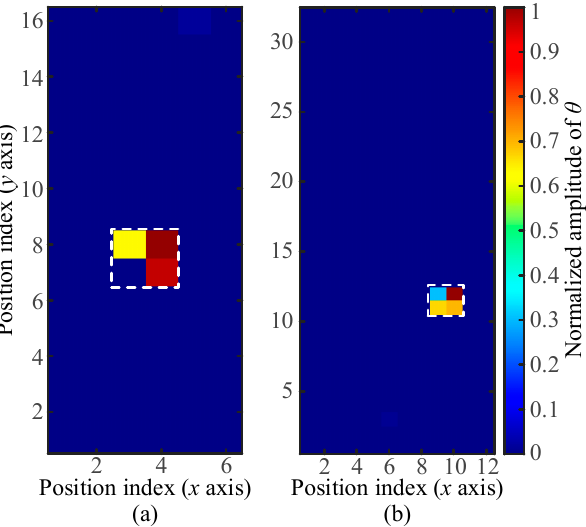
Figure 9. Localization results of a large-area touch with the reference database of a small area under the equivalent condition of averaged stress: ( a ) Localization results of unknown touch and the reference database with the A t combination of 64 and 16 mm 2 and ( b ) localization results of unknown touch and the reference database with the A t combination of 16 and 4 mm 2 .